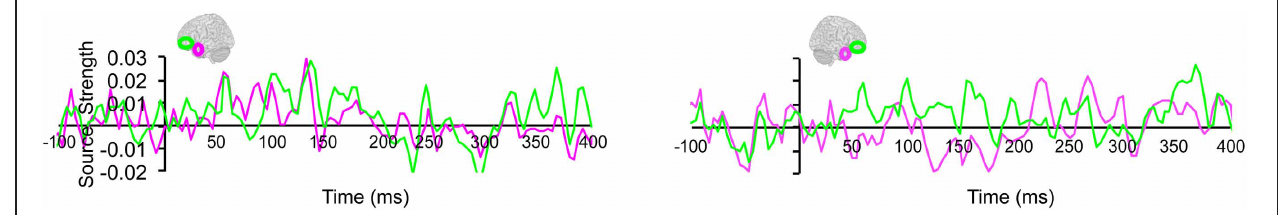
FIGURE 11 | Regional waveforms showing the difference between integration responses in congruent and incongruent AV object trials, averaged across participants, in the left and right hemispheres.